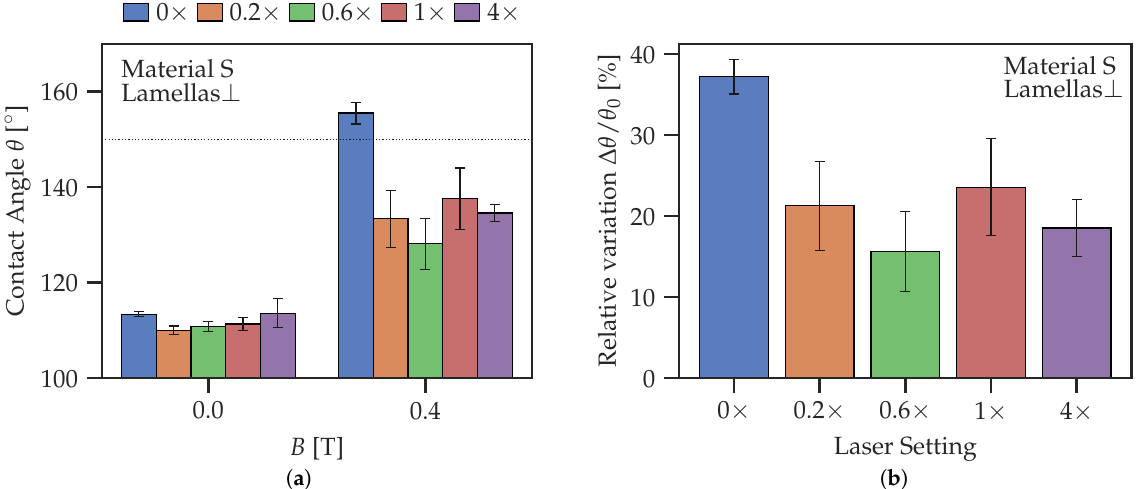
Figure 13. Contact angles on lamellar structures from material S in the settings. ( a ) Absolute value of CA. ( b ) Relative change in CA caused by magnetic